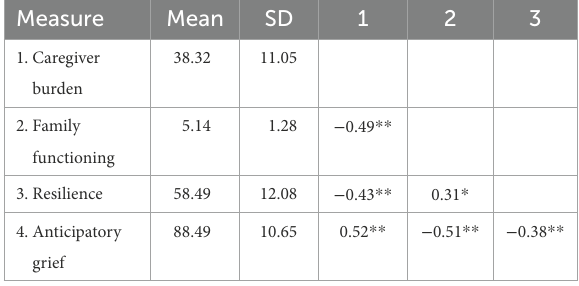
TABLE 2 Means, standard deviations (SD), and intercorrelations among study measures.